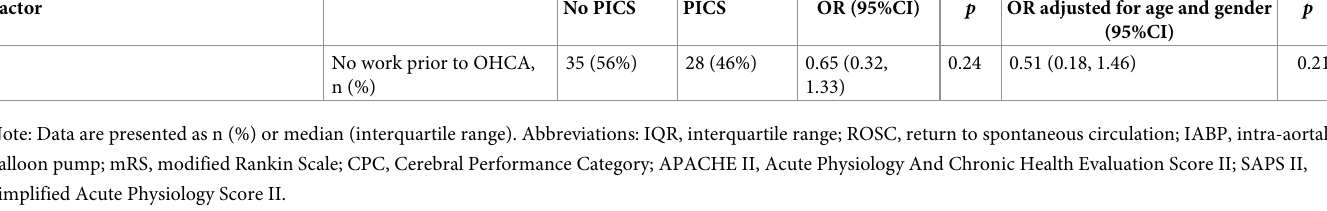
95%CI 1.8 to 117.56, p = 0.012). Secondary endpoint: PICS 12 months after hospitalization Of 110 patients, 52 patients (47.3%) showed evidence of PICS after 12 months with 36.7% showing physical impairment, 22.2% cognitive impairment, and 12.7% psychological distress ( Fig 2 ). We assessed potential predictors for PICS ( Table 3 ) and found initial severity of illness scores (APACHE II: OR 1.08, 95%CI 1.02 to 1.14, p = 0.008) and functionality at discharge (poor mRS score: OR 3.97, 95%CI 1.42 to 11.12, p = 0.009; and CPC score: OR 3.22, 95%CI 1.29 to 8.04, p = 0.012) to be associated with PICS. In addition, risk for PICS was lower in patients not needing rehabilitation (OR 0.31, 95%CI 0.12 to 0.82, p = 0.019) and in turn increased with longer duration of the rehabilitation (in days) (OR 1.24, 95%CI 1.03 to 1.5, p = 0.027). We also investigated, in the 93 patients that were assessed at both time points, whether PICS at 3-month would persist after 12-month. Results stratified according to PICS at both time points are shown in Fig 3. Chi-square test between PICS at 3 and 12 months was signifi- cant, X 2 (1, N = 93) = 23.6, p < .001. Further, we investigated how the different domains of PICS were inter-correlated by calculation of a correlation matrix at 3- and 12-month as shown